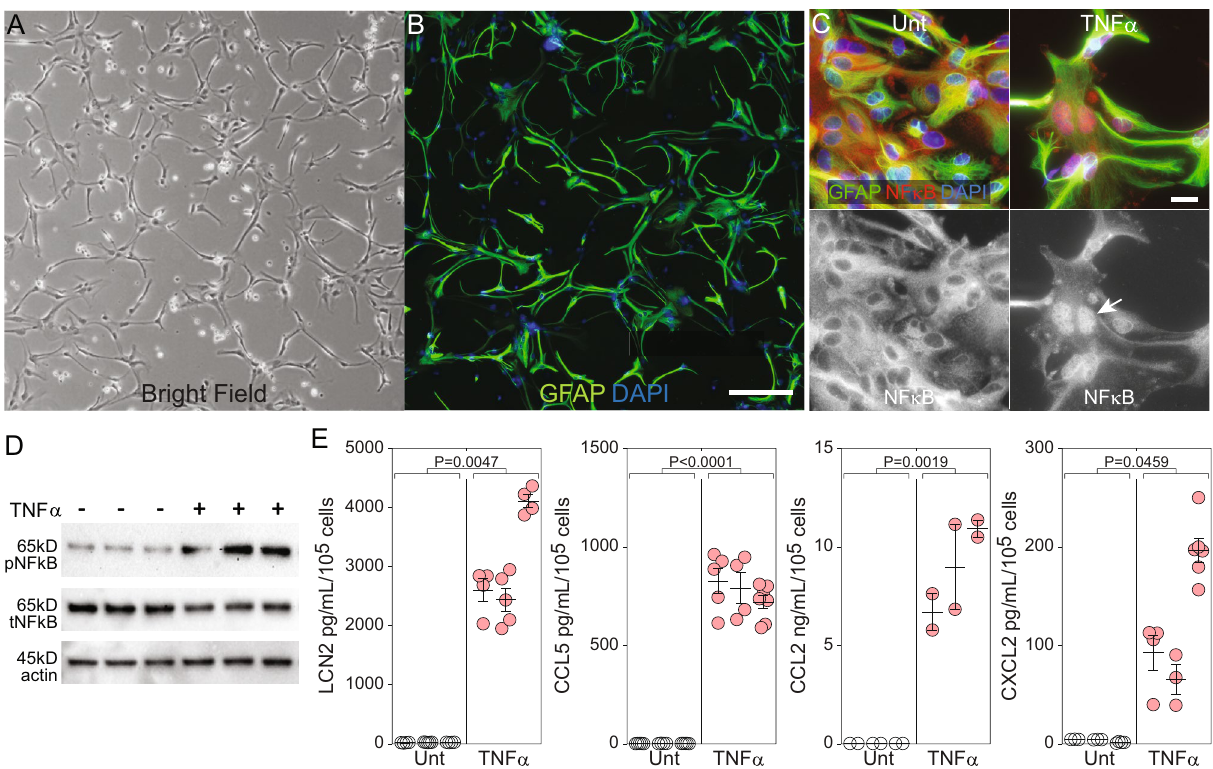
Figure 1. TNFα drives inflammatory reactivity in astrocytes grown under serum-free conditions. ( A ) Bright- field image of purified astrocytes cultured in serum-free conditions for at least 14 days indicating quiescent phenotype. Cells were seeded at 500,000 cells/well in 6-well plates. Scale bar = 200 µm. ( B ) Fluorescent image of astrocytes (GFAP = green; DAPI = blue) verifying resting morphology. Scale bar = 200 µm. ( C ) Fluorescent images (GFAP = green; NFκB = red; DAPI = blue) of resting astrocytes under untreated conditions (Unt) or following stimulation with TNFα (10 ng/mL for 1 h) indicate nuclear translocation (white arrow) of NFκB consistent with signaling via this pathway. Scale bars = 20 µm. ( D ) Western blot analysis of cell lysates indicating that TNFα (10 ng/mL for 1 h) stimulation of the quiescent astrocytes induced robust phosphorylation of NFκB. Actin is shown as a loading control. Immunoblots derive from the same membrane. Uncropped blots are available in the Supplementary Information. ( E ) Resting astrocytes were left unstimulated (Unt) or treated with TNFα (10 ng/mL for 24 h). Supernatants were analyzed by ELISA to measure secretion of Lcn2, CCL5, CCL2, and CXCL2. Data are normalized to pg/mL per 10 5 input cells. Each symbol represents one well from 3 separate experiments, shown in nested layout. Mean ± SEM is shown for each biological replicate. P-values were calculated using mixed model nested t-tests. Western blots and fluorescent images are representative of at least 3 separate experimental